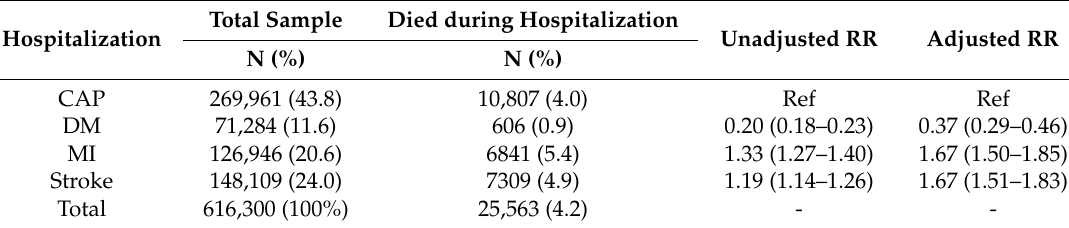
Table 2. Inpatient mortality in hospitalized older adults with CAP compared with DM, MI, and